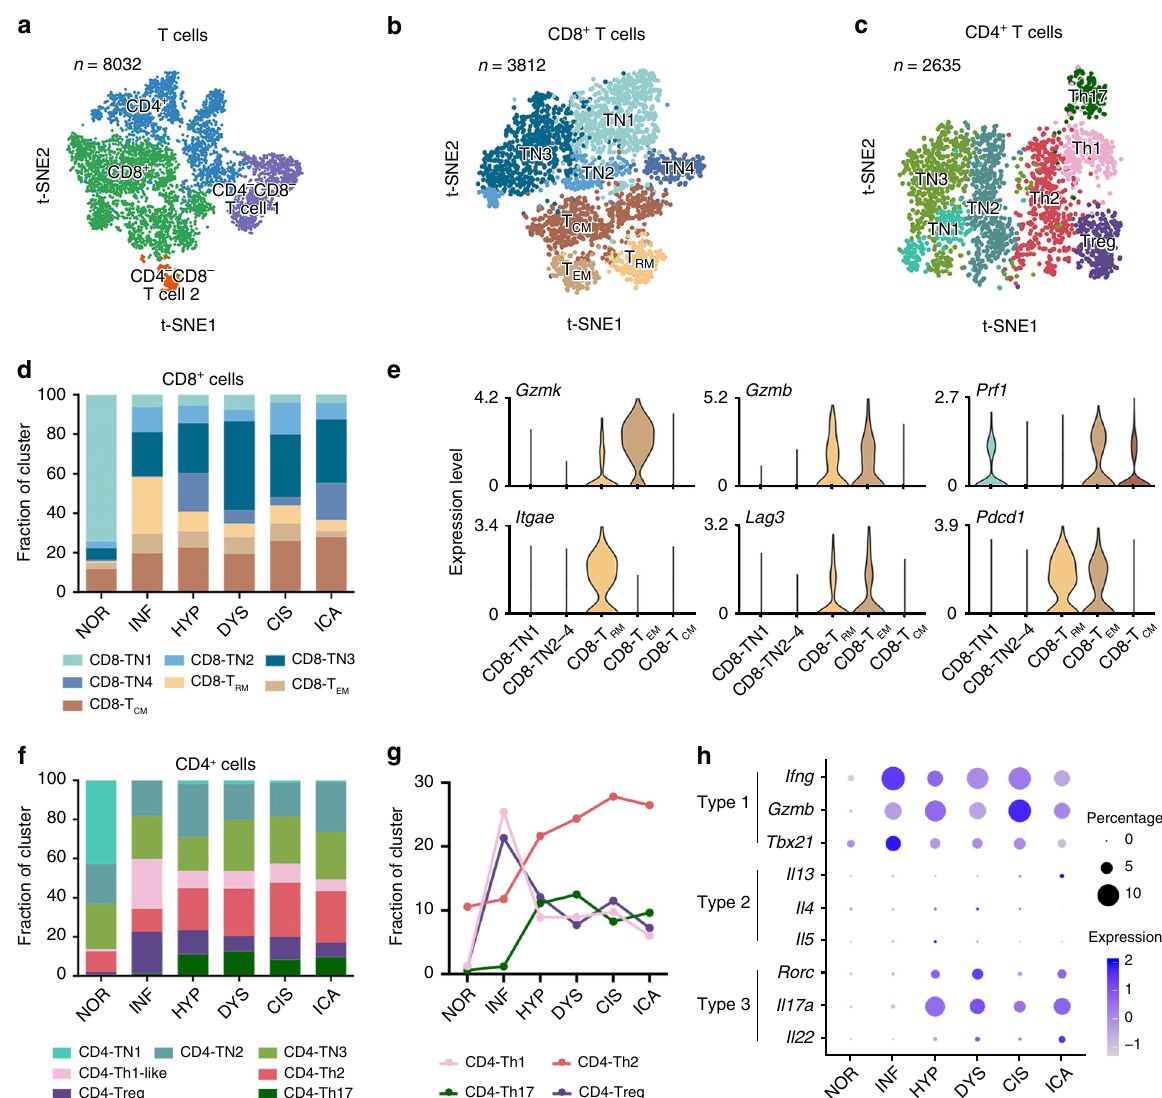
Fig. 5 Characterization of multiple changes in T cell subtypes. a – c tSNE plots of 8032 T cells, 3812 CD8 + T cells, and 2635 CD4 + T cells. Color indicates cluster. d Histogram showing CD8 + T cell composition across the six pathological stages. Color indicates cluster designated in b . e Violin plots of marker gene expression among CD8 + T cell clusters. f Histogram showing CD4 + T cell composition across the six pathological stages. Color indicates cluster designated in c . g Line chart displaying changing trend of the four selected cluster proportions across the six pathological stages. h Bubble plot showing scale normalized expression of three representative genes involved in type 1, 2, and 3 immune response, respectively, from stage INF to stage ICA. Size of dots represents percentage of cells expressing corresponding genes in the